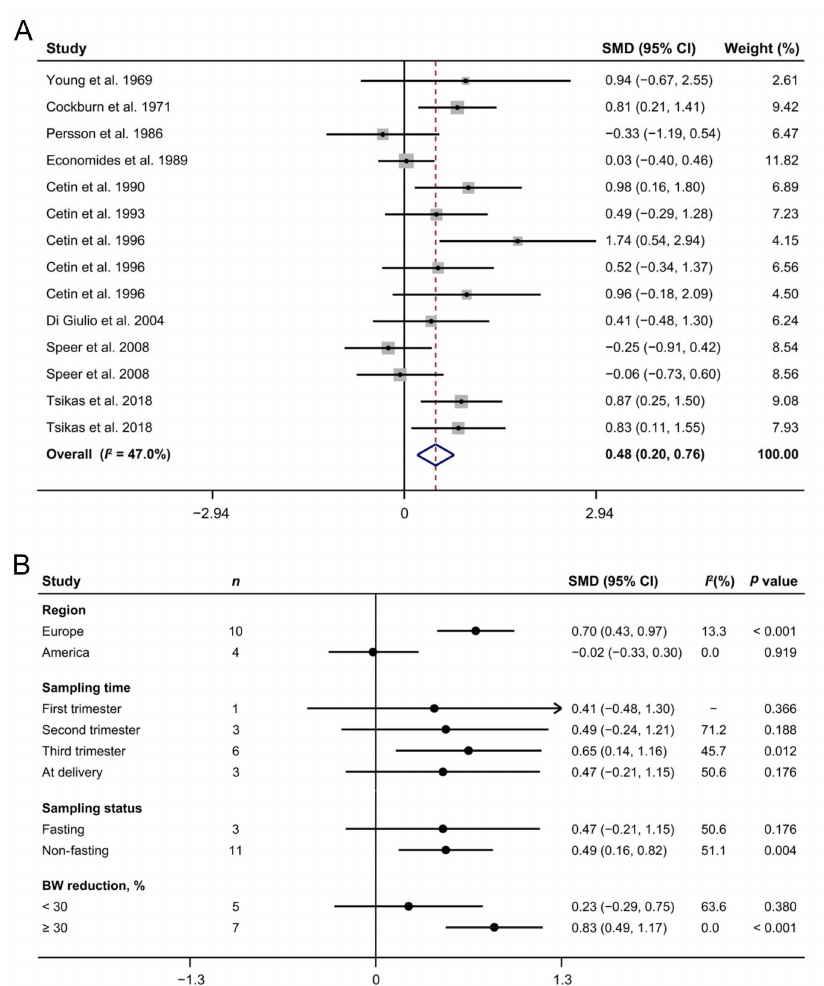
Figure 2. The forest plot shows the maternal arginine concentrations in intrauterine growth restriction pregnancies ( A ) as well as their subgroup analyses ( B ). The solid black circles mean the estimate of SMD. The horizontal lines indicate the 95% CI of this effect, and the sizes of the gray boxes suggest the relative weight of each publication. An open diamond denotes the overall SMD determined using a random effects model. The value on the x-axis corresponds to the SMD of maternal arginine concentration. Heterogeneity among the publications was estimated using the I 2 statistic, with 0–25%, 25.1–75%, and 75.1–100% representing low, moderate, and high degrees of heterogeneity, respectively. BW, body weight; SMD, standard mean